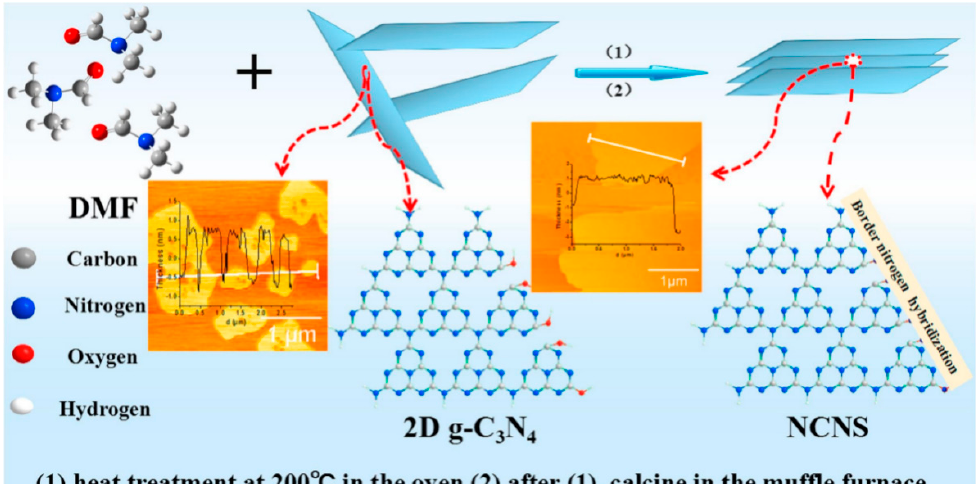
Figure 4. Scheme of the formation process from the bulk-C 3 N 4 to the g-C 3 N 4 nanosheets (NCNS) sample. Reprinted from [57], Copyright (2018), with permission from Elsevier.